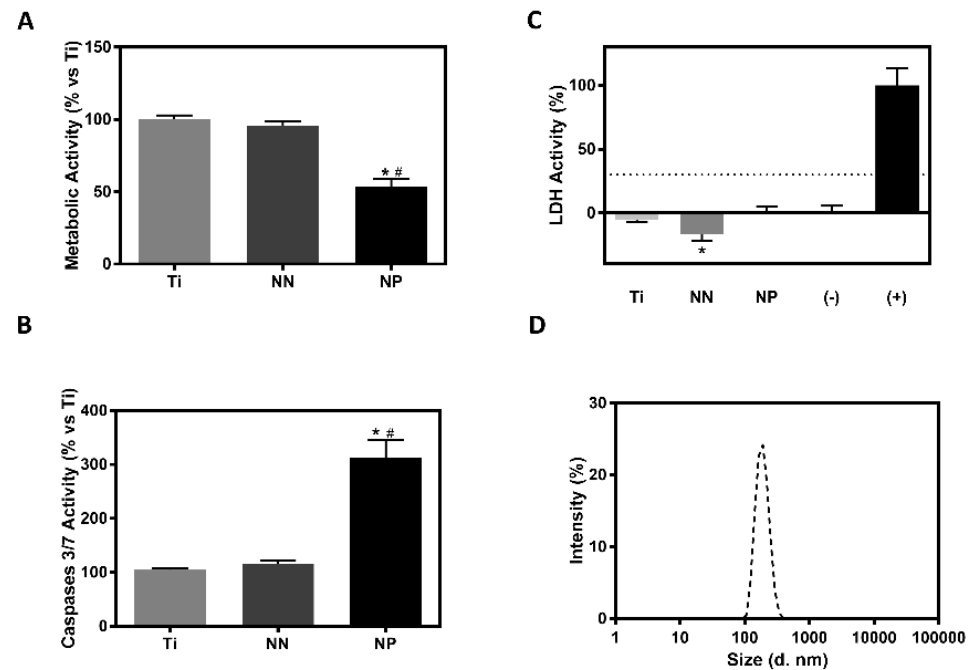
Figure 2. Analysis of particle release from the di ff erent surfaces and its e ff ect on biocompatibility. Values represent the mean ± SEM ( n = 6; A, B, C) ( n = 3; D). ( A ) Metabolic activity (% vs. Ti) of human gingival fibroblasts (hGFs) cultured with conditioned media. ( B ) Caspases 3 / 7 Activity (% vs. Ti) of hGFs cultured with conditioned media. ( C ) LDH activity (% vs. ( + )) of hGFs cultured with conditioned media; hGFs cells cultured with tissue culture plastic (TCP) conditioned media are considered (-) and hGFs cells treated with Triton X-100 1% are considered ( + ). Results were statistically compared by analysis of variance (ANOVA) and Bonferroni as post hoc: * p < 0.05 versus Ti for LDH activity and by Kruskall Wallis for metabolic activity and caspases 3 / 7 activity: * p < 0.05 versus Ti; # p < 0.05 versus NN. ( D ) Diagram that represents the size distribution and the intensity of the nanoparticles in water cultured with NP surfaces, analyzed with a